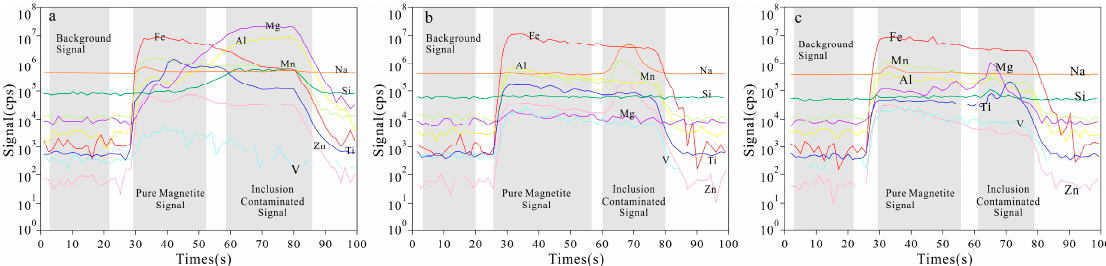
Figure 8. Time-resolved analytical signals of a LA-ICP-MS analysis from disseminated- and massive- magnetite ores. ( a ) Disseminated magnetite ores (T2); ( b ) Massive magnetite ores (T3); ( c ) Massive magnetite ores (T4). Suspected fluid inclusions are characterized by high Si, Al, Mn, Mg, Ti, and Zn intensities (cps counts per second).